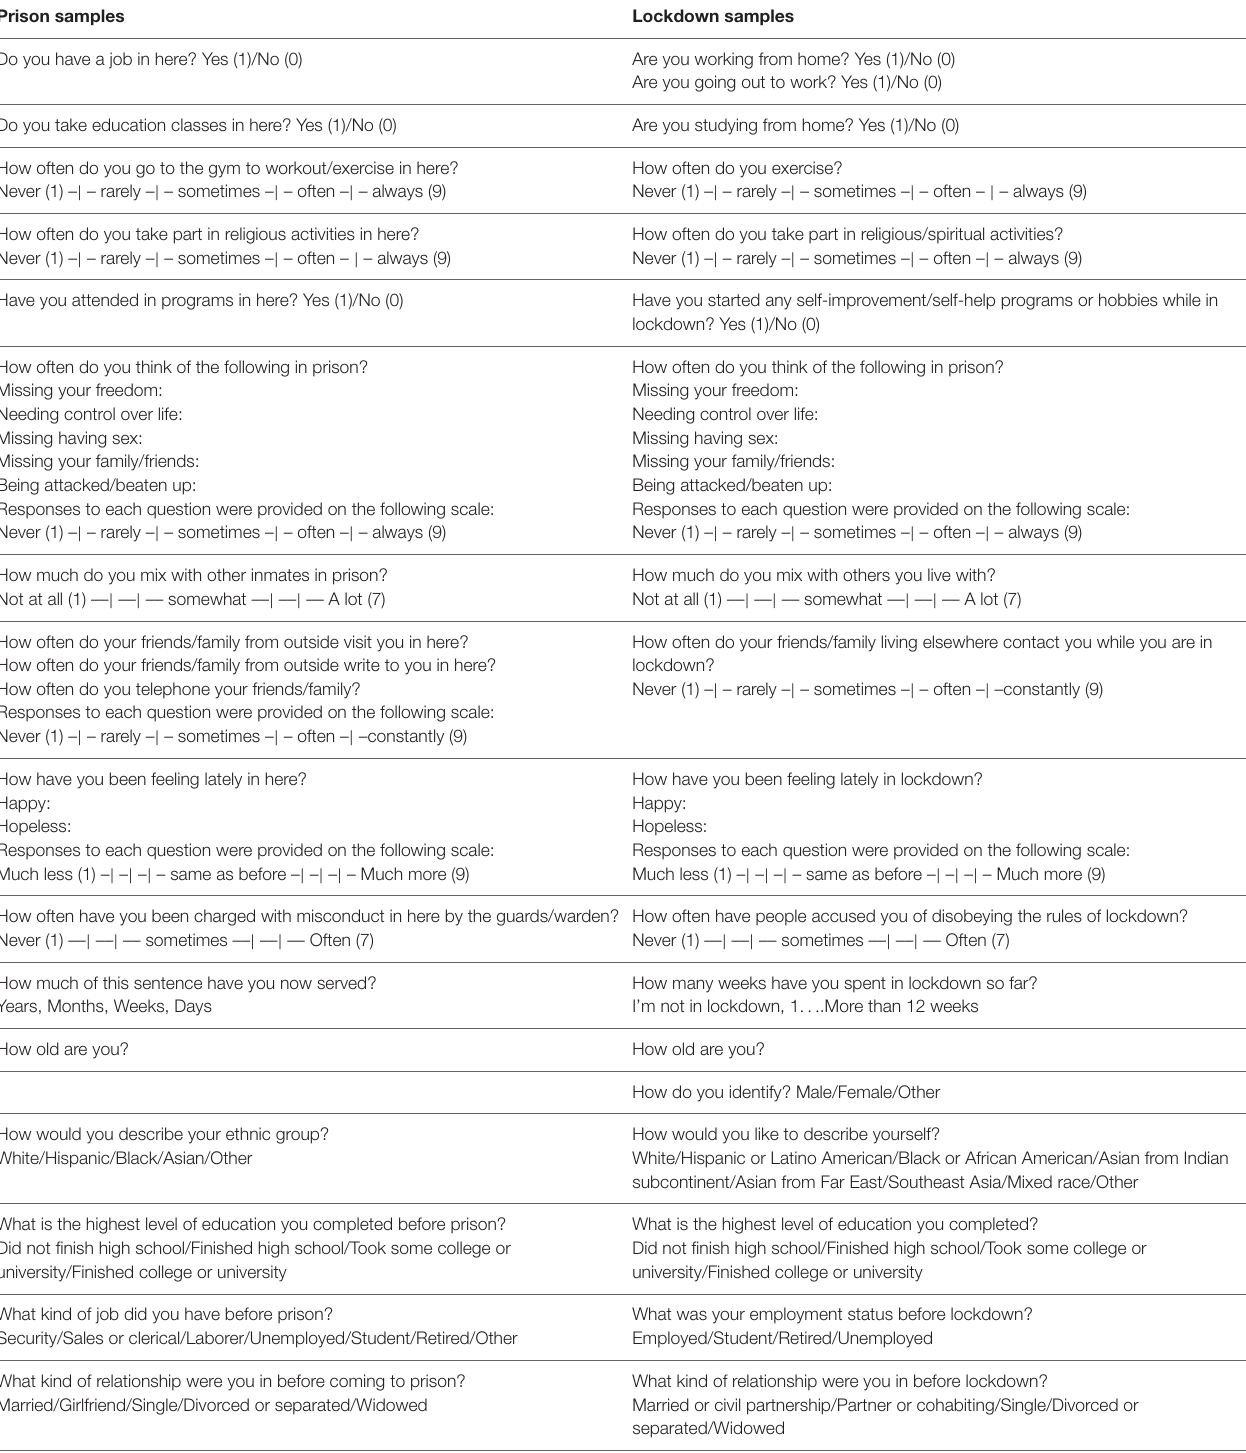
TABLE A1 | Items and response scales used in present analyses (scale size and coding of variables shown in